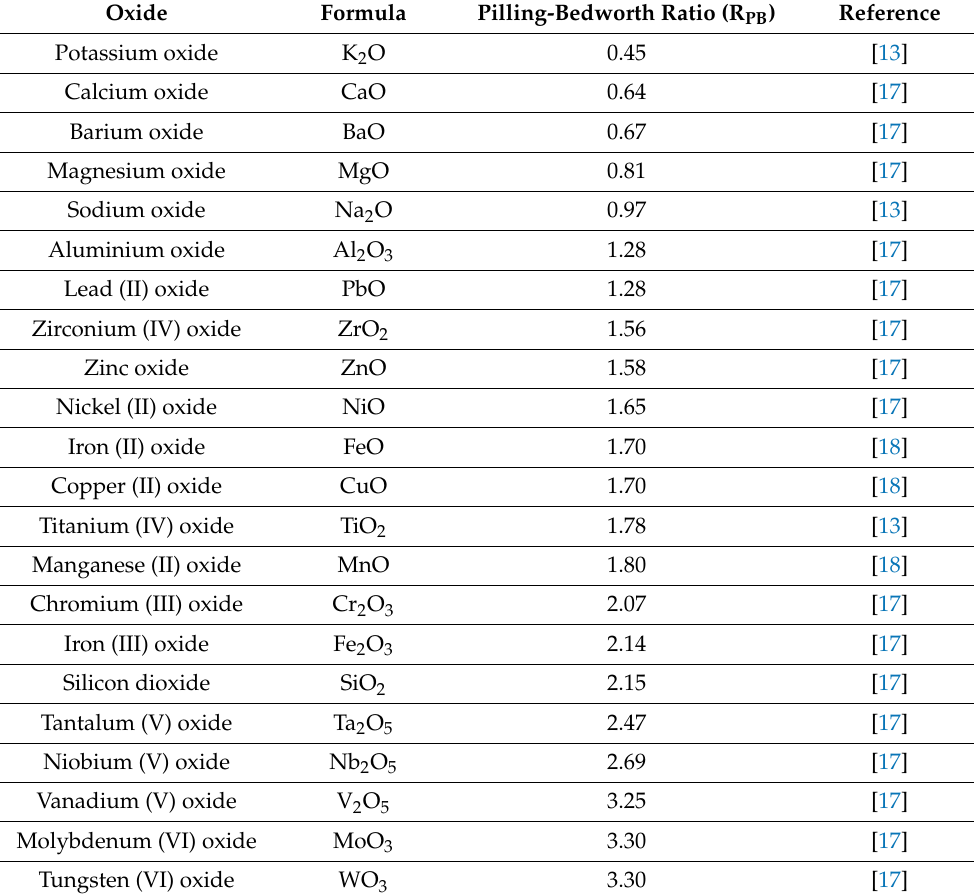
Table 1. Pilling-Bedworth ratios (R PB ) of metallic